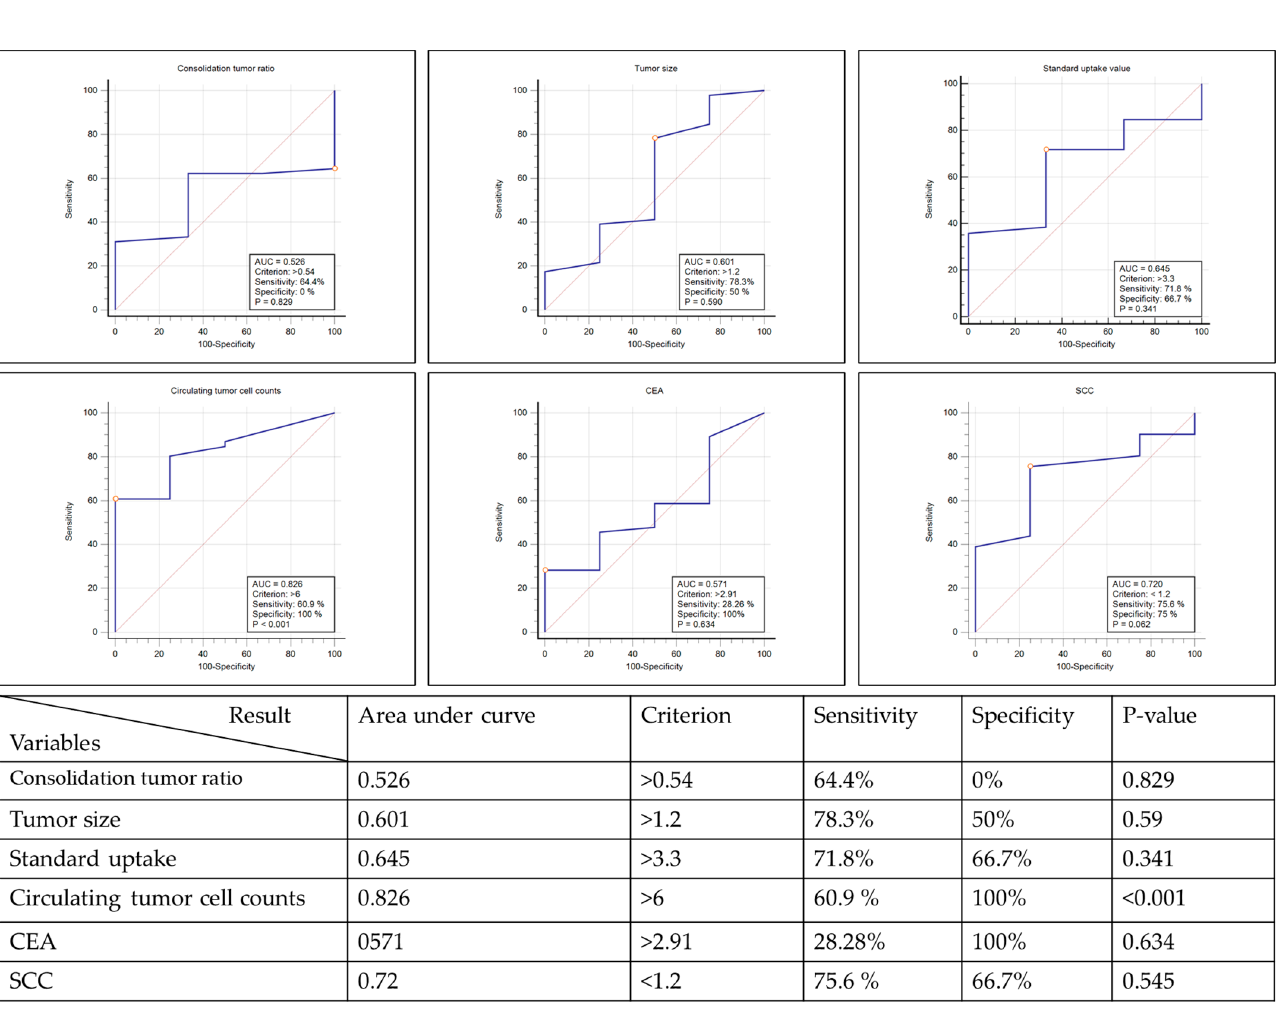
Figure 1. Receiver operating characteristic (ROC) curve of different tumor markers in this study cohort. Table 2. Comparative presentations of benign and malignant pulmonary lesions. Table 4. Logistic regression for model